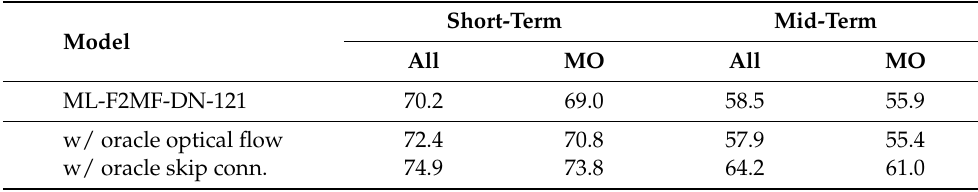
Table 8. Evaluation of the forecasting model with oracle skip